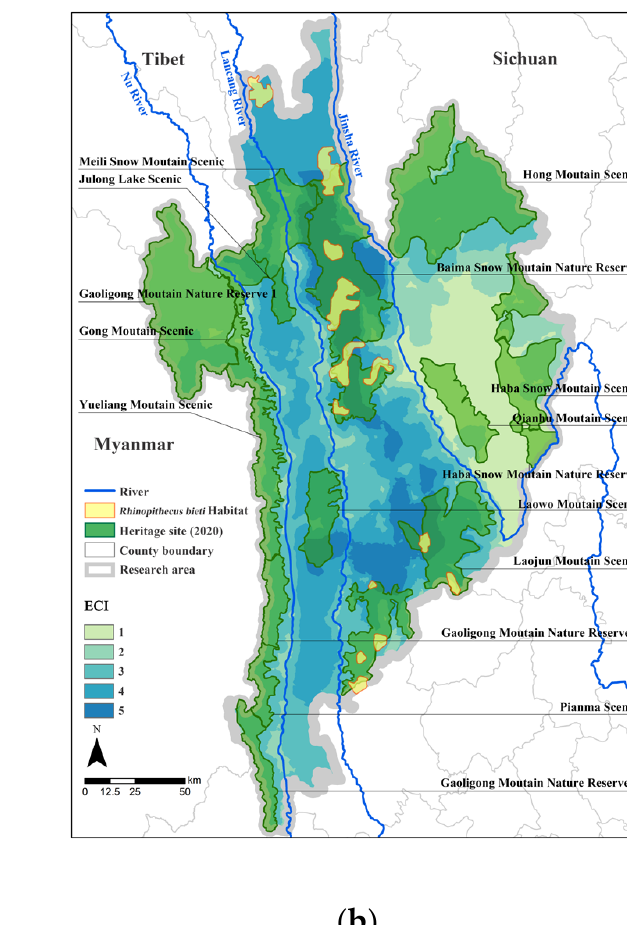
Table 8. Results of ECI classification in the four parts of the Three Parallel Rivers Natural World Heritage Site. Class of ECI West Bank of the Nu River/%